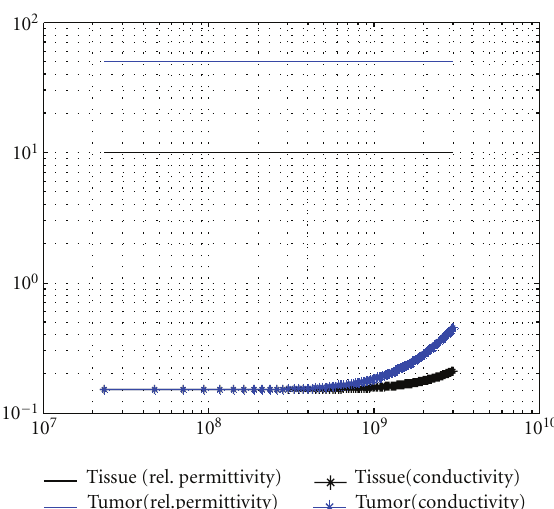
Figure 3: Dielectric Profiles of the breast volume with healthy tissue and tumor using the Debye model. The Debye model is given by jσ/ (2 π f ε ε ε / (1+ j f/ f ε ε ( f ) = ε = 8 . 854 × s − p ), where ∞ − ∞ ) 0 )+( 0 10 − 12 F / m, f p = 25GHz, and σ = 0 . 15S / m. For healthy tissue, ε s = 10 and ε ∞ = 7. For the tumor, ε s = 50 and ε ∞ = 35